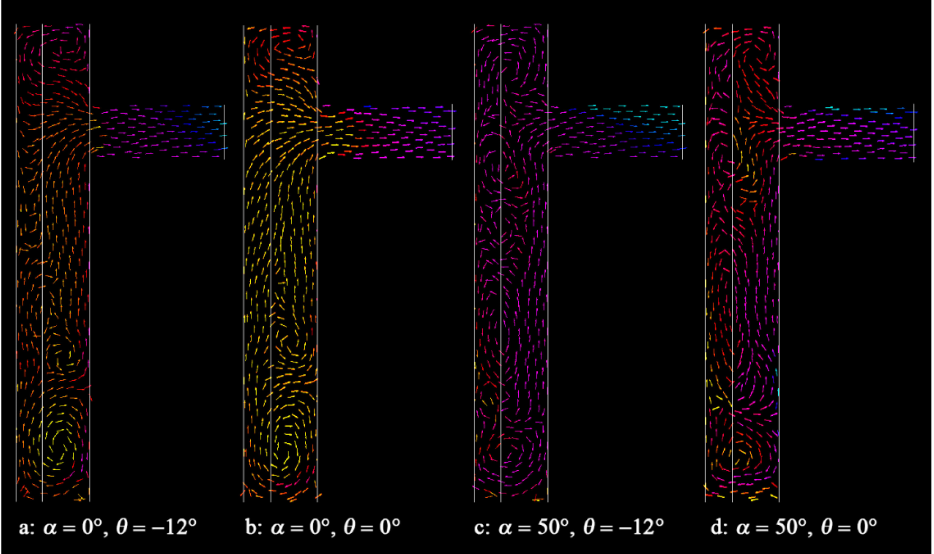
Figure 11. Vector at the r - z plane for α = 0 ◦ and α = 50 ◦